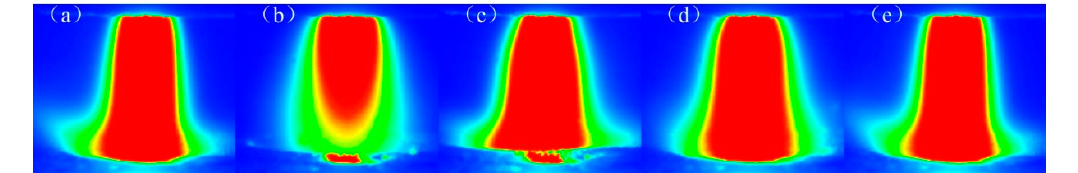
Figure 9. Comparison of arc images at positive polarity stage. ( The color bar of this figure is same as figure 6.)